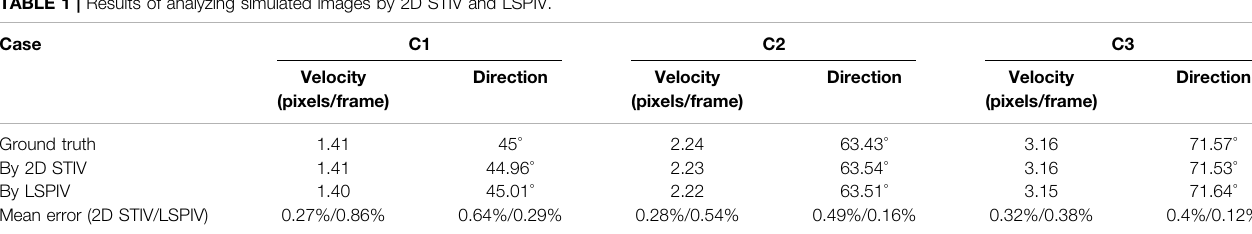
TABLE 1 | Results of analyzing simulated images by 2D STIV and